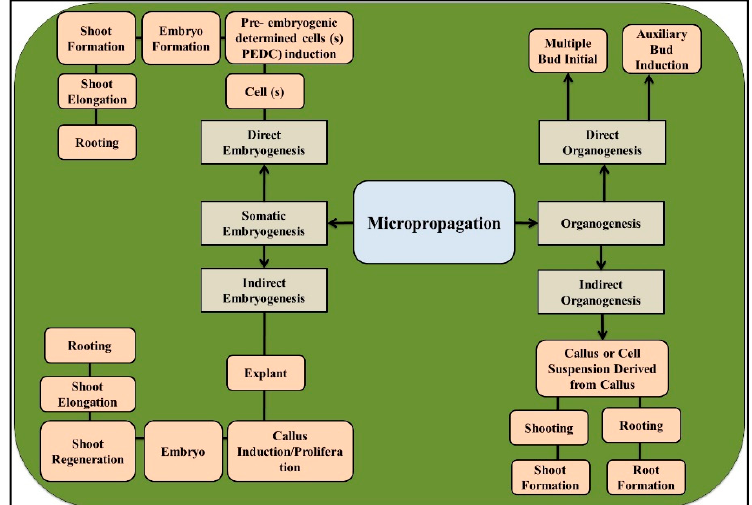
Figure 2. Schematic graph of different regeneration methods applied in micropropagation techniques in plants. Micropropagation is divided into two mainstream groups, namely, organogenesis and somatic embryogenesis (SE). Each class is also classified into direct and indirect methods. The general pattern of direct embryogenesis starts from tissue (s) or cell (s) in the lack of callus proliferation, through pre-embryogeneic determined cells (PEDCs). PEDCs are those types of plant cells that have the capability of embryonic development and need optimum condition (s) as well as PGRs to for embryogenesis. In the second type of SE, which is indirect embryogenesis, embryos are formed and developed after callus proliferation by using PGRs. Similarly, organogenesis is divided into direct and indirect pathways. In direct route, the plant is manipulated through the initiation of explants on culture media. Indirect organogenesis is achieved via manipulation of plants through callus induction and organ formation.